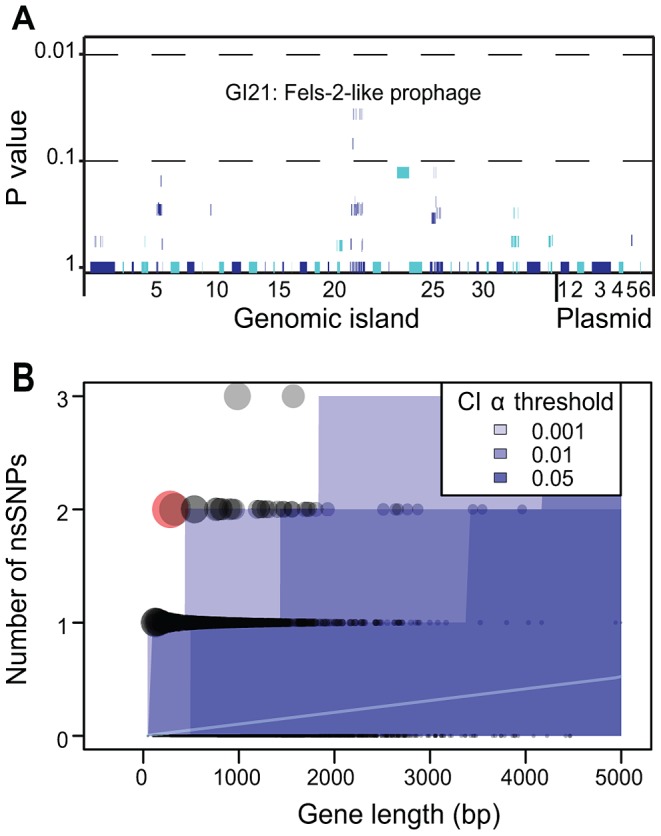
Lack of association of CDSs in the accessory genome with outbreak clades and statistical test of neutrality of non-synonymous mutations in the core genome.A) Likelihood of association of individual CDSs within the accessory genome with outbreak clades. Each of the 79 genomic islands and plasmids is indicated by alternating light and dark blue segments consisting of one vertical line per CDS. Individual genomes were assigned to one of four outbreak clades or one of 28 non-outbreak clades. Only eight CDSs within GI21 were significantly associated with all outbreak clades (Fisher exact test, p = 0.032). After a Bonferroni correction for multiple tests, no CDS was significantly associated with outbreak clades. B) Numbers of non-synonymous mutations per CDS in the non-recombinant, non-repetitive core genome as a function of gene length whose mean expectations are indicated by an internal white line. Each gene is represented by a circle, whose size is proportional to the deviation according to a χ2 statistic from theoretical expectations of a non-parametric test (Figure S5). Shades of blue indicate different α-thresholds (0.05, 0.01, 0.001) of the confidence intervals of the theoretical expectations, where 0.05 indicate CI 95%. The sole outlier identified in Figure S7B is indicated in red.